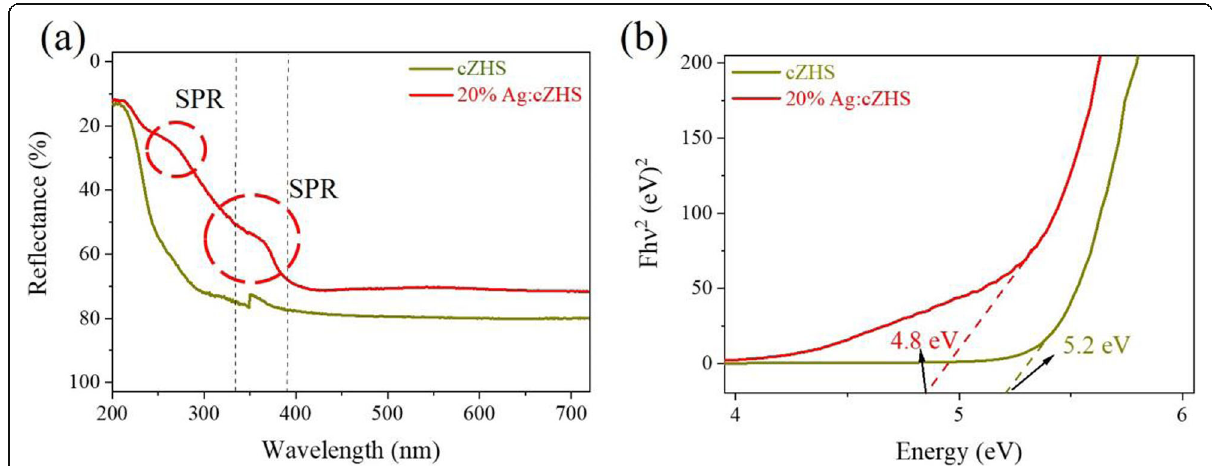
Fig. 7 DRS spectra ( a ), and Kubelka-Munk function ( b ) of cZHS and 20% Ag: